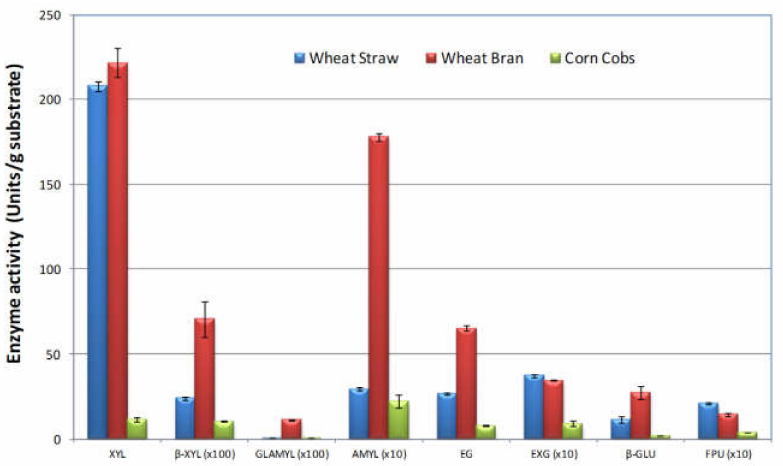
Figure 1. Production of cellulolytic, hemicellulolytic and amylolytic enzymes by F. oxysporum F3 grown under solid state cultivation on wheat straw, wheat bran and corn cobs as carbon